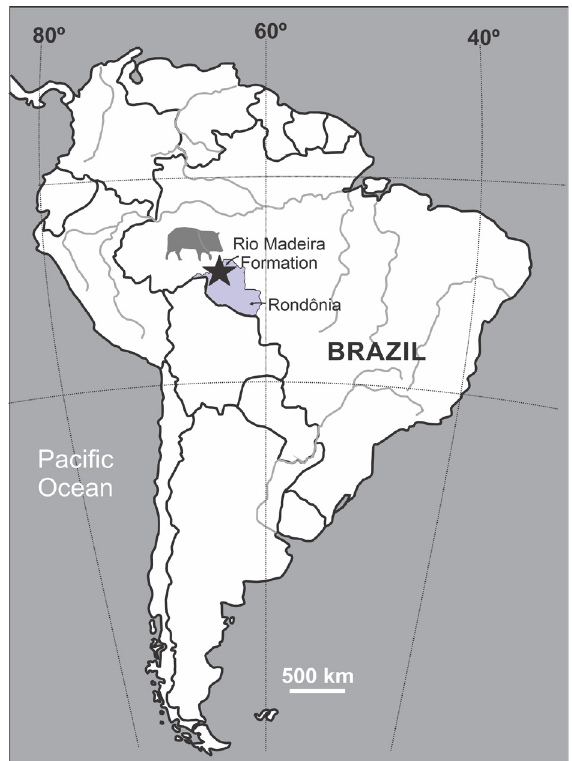
Figure 1. Geographic location of the Rio Madeira Formation (Pleistocene), State of Rondônia,